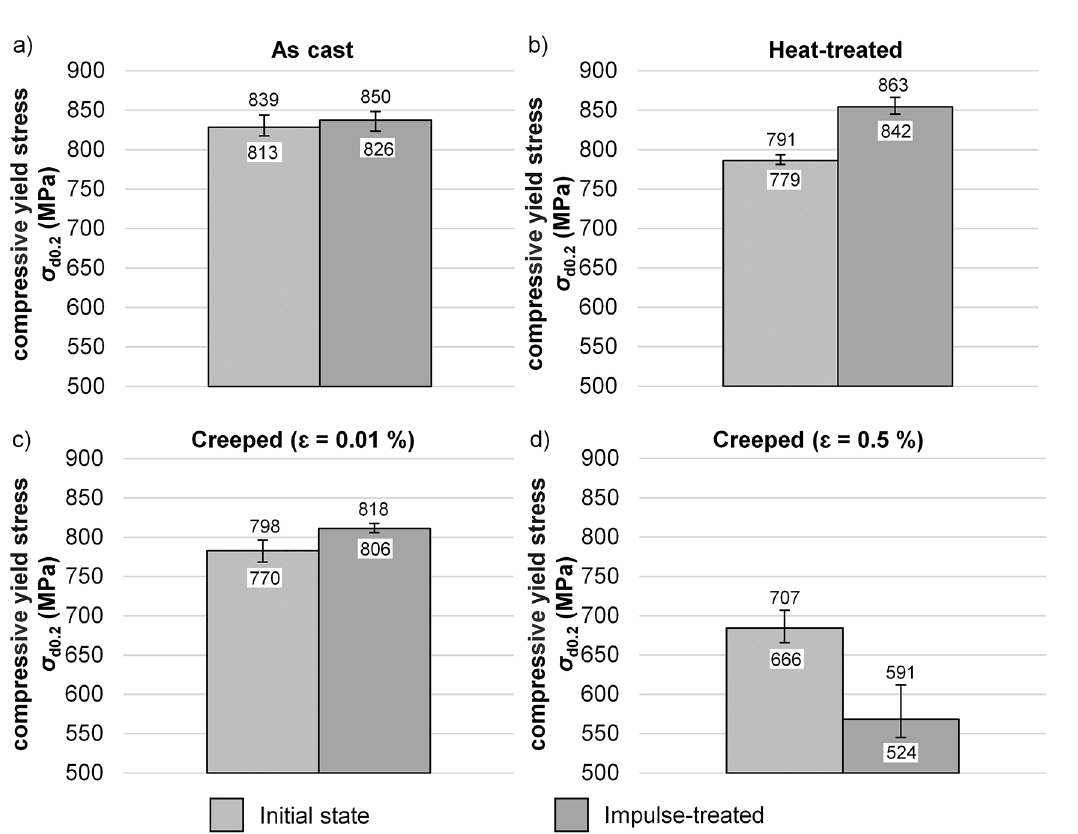
Figure 5. Averaged compression limits determined from the CMSX-4 specimens in their initial condition and with prior current-impulse treatment (test parameters according to Table 3, test series V3 and V4) for a) cast, b) heat treated c) creep strain of 0.01 % and d) creep strain of 0.5 %